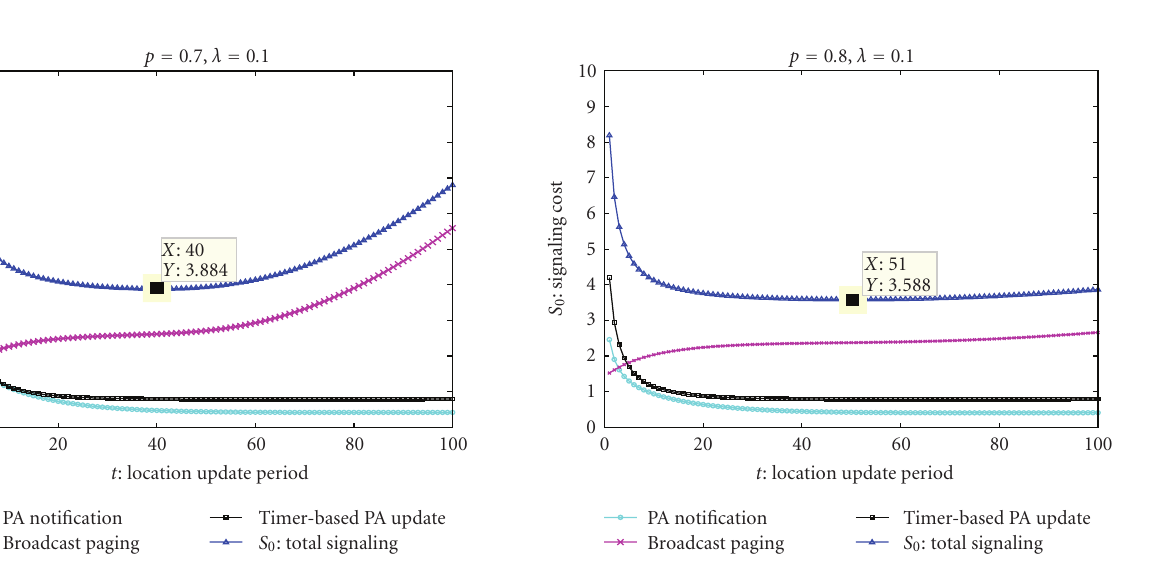
Figure 13: Signaling cost: high mobility and low message arrival rate.